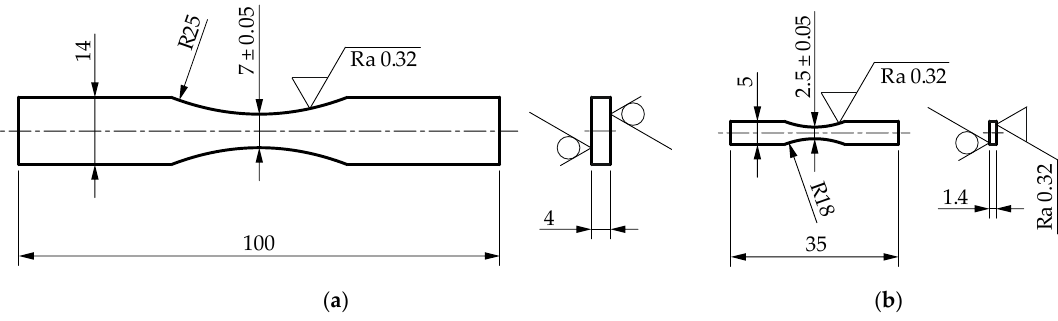
Figure 7. Geometry of the flat specimen for fatigue testing, cut from a 4-mm-thick plate: ( a ) standard specimen; ( b ) mini-specimen.